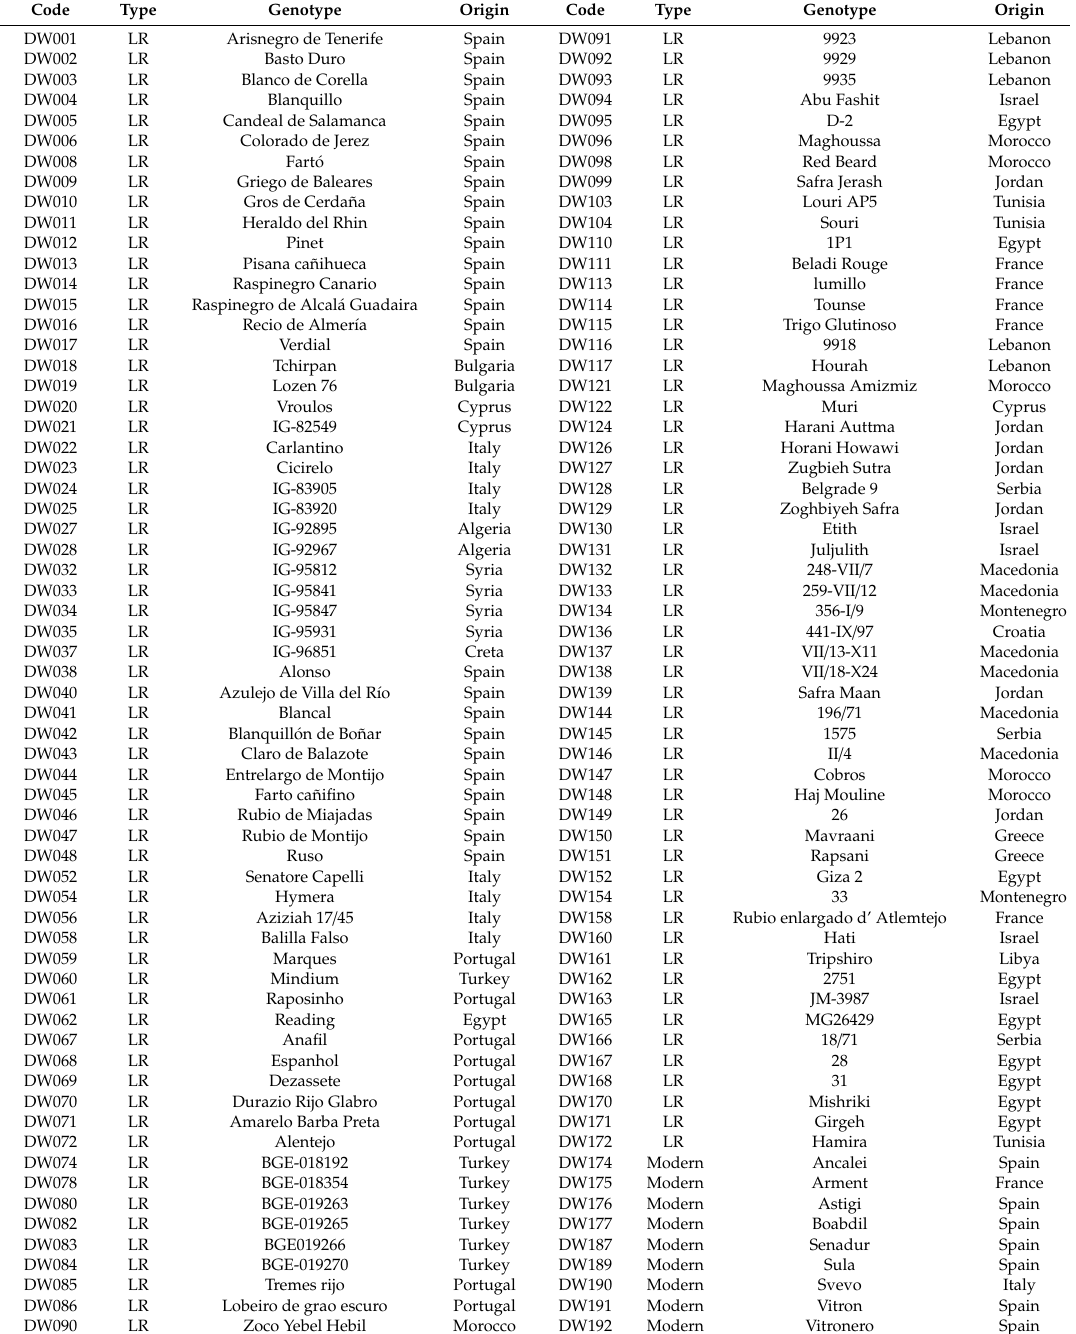
Table 8. Genotypes included in the Mediterranean panel. LR,